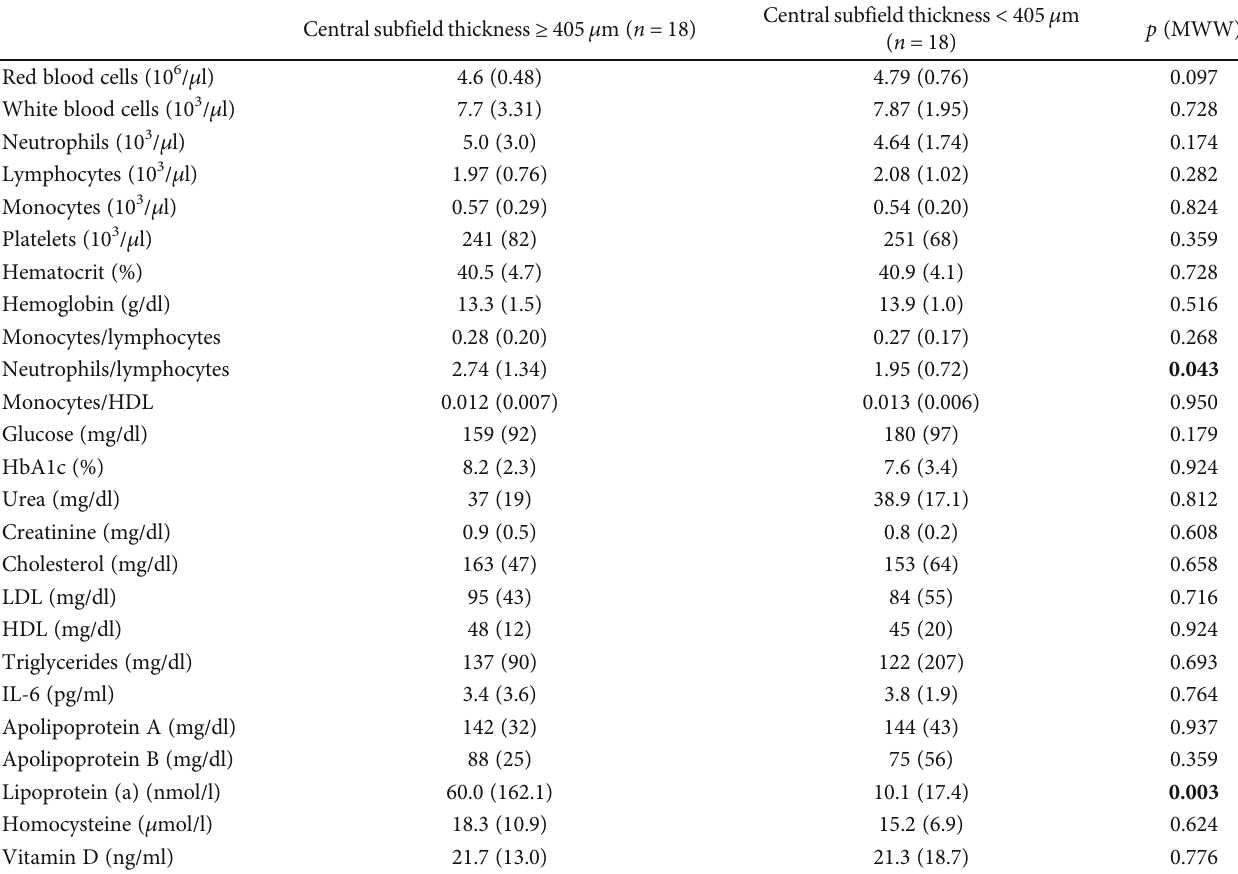
Table 5: Association between laboratory variables and central sub fi eld thickness on optical coherence tomography. Laboratory variables are summarized as median (IQR: interquartile